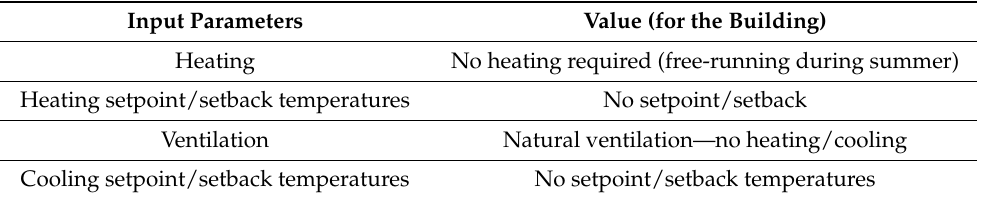
Table 8. The model parameters.